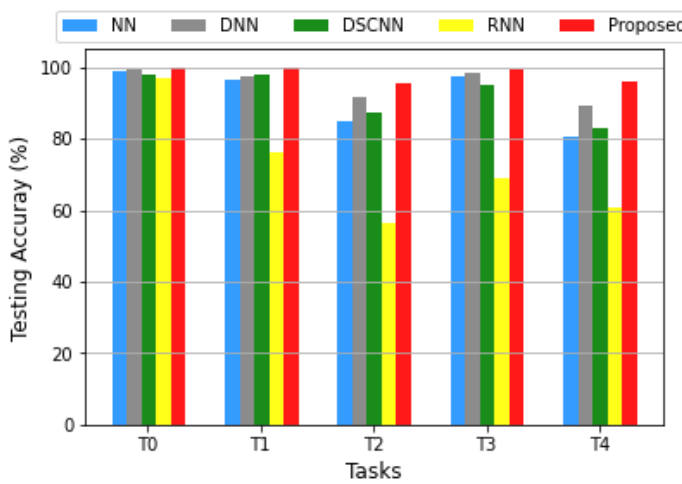
Figure 11. The results of the different compared methods for different tasks.